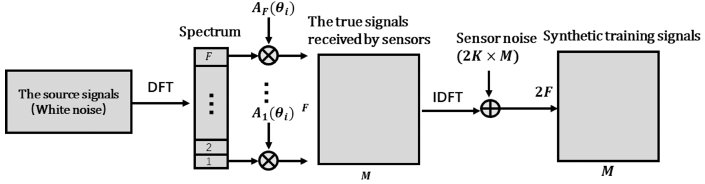
Figure 3. The generation process of data set